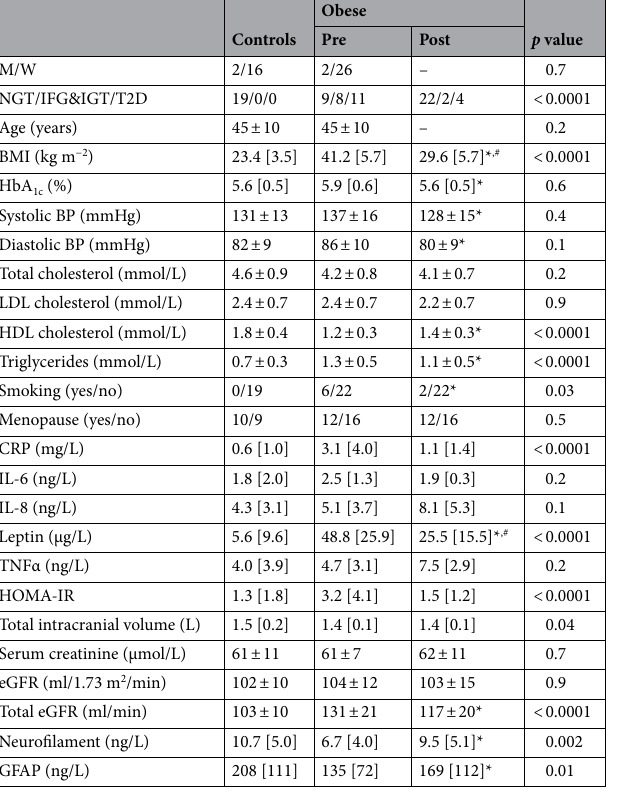
Table 1. Anthropometric and biochemical characteristics of the study participants. Entries are mean ± SD, or median [interquartile range], as appropriate. p value for the comparison between obese pre and lean individuals; * p < 0.05 for obese before and after bariatric surgery; # p < 0.05 for the comparison obese post vs. lean individuals. BMI body mass index, NGT normal glucose tolerance, IFG impaired fasting glucose, IGT impaired glucose tolerance, T2D type 2 diabetes, BP blood pressure, CRP C-reactive protein, HOMA-IR homeostatic model assessment of insulin resistance, eGFR estimated glomerular filtration rate, GFAP glial fibrillary acidic